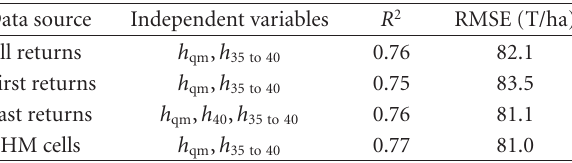
Table 2: Regression models and their